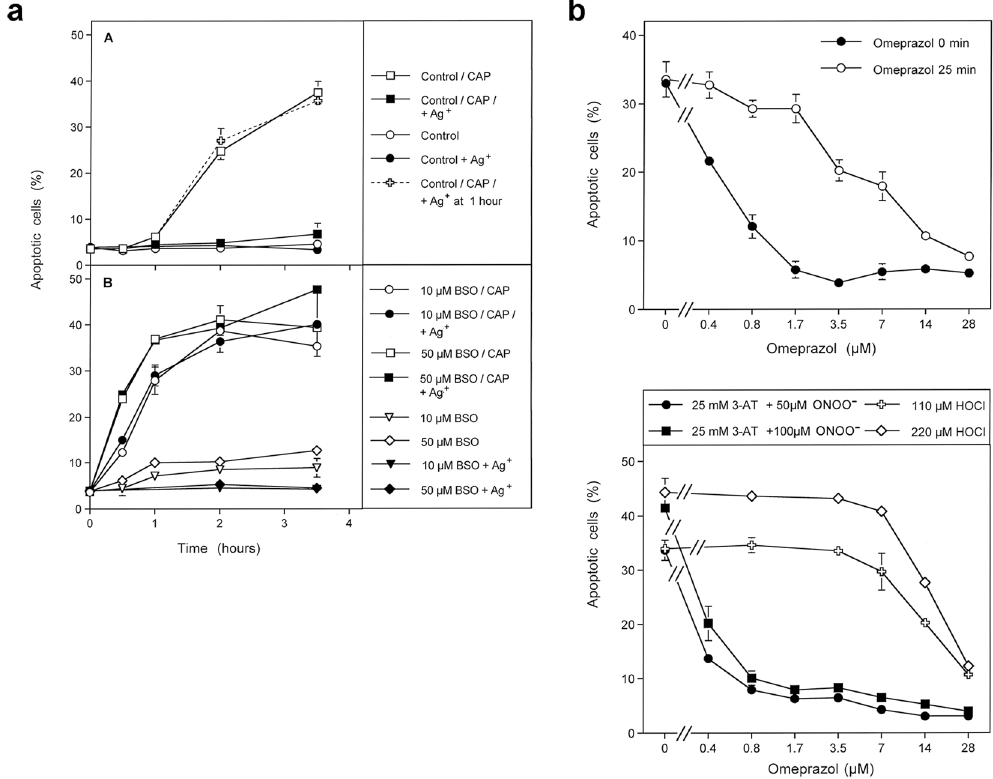
Figure 8. The role of aquaporins and proton pumps for CAP-mediated apoptosis induction. ( a ) The role of aquaporins for intercellular apoptosis-inducing signaling after CAP treatment. Tumor cells were pretreated in the absence of inhibitors (Control) or in the presence of 10 µ M or 50 µ M of buthionine sulfoximine (BSO), an inhibitor for glutathione synthesis, for 14 h. The cells were washed and either received no further treatment, addition of 5 µ M of the aquaporin inhibitor Ag + , treatment with CAP for 1 min plus 25 min incubation or CAP treatment plus Ag + . The percentages of apoptotic cells were determined kinetically. Part A shows that control cells required a 1 hour lag phase before they responded to CAP treatment with apoptosis induction. CAP-mediated apoptosis induction was completely blocked when Ag + had been added at 0 min of incubation, whereas there was no inhibitory effect when Ag + had been added 1 hour after the beginning of the incubation. Part B shows that pretreatment of the cells with BSO, i. e. inhibition and consumption of GSH, allowed for a faster onset of CAP-mediated apoptosis induction that was no longer inhibited by Ag + . Statistical analysis: A: Apoptosis induction after CAP treatment at 2 h and later, as well as inhibition by Ag + added before CAP treatment was highly significant (p < 0.001), whereas addition of Ag + 1 h after CAP treatment was without significant inhibitory effect. B: Apoptosis induction after pretreatment with BSO, followed by CAP treatment was highly significant (p < 0.001), whereas Ag + did not cause significant inhibition. ( b ) The role of proton pumps for CAP-mediated apoptosis induction. Upper graph: The proton pump inhibitor omeprazol was added at increasing concentrations to MKN-45 cells either at the beginning of CAP treatment for 1 min or 25 min after CAP treatment. Apoptosis induction was determined after 3.5 h. The result shows that later effects of CAP treatment are less sensitive to the proton pump inhibitor than earlier ones. Lower graph. Model experiments with omeprazol using defined signaling pathways for apoptosis induction. Increasing concentrations of omeprazol were added to MKN-45 cells that were either treated with the indicated concentrations of the catalase inhibitor 3-AT plus peroxynitrite (ONOO − ) or HOCl. The percentages of apoptotic cells were determined after 2 h. The result shows that ONOO − -mediated apoptosis induction was more efficiently inhibited by omeprazol than HOCl-dependent apoptosis induction. Statistical analysis: Upper graph: When omeprazol had been added at 0 min, the inhibitor caused highly significant inhibition at 0.4 µ M and higher concentrations, whereas it caused highly significant inhibition at 3.5 µ M and higher when added at 25 min (p < 0.001). Lower graph: Inhibition of ONOO − -mediated apoptosis induction was highly significant (p < 0.001) at 0.4 µ M omeprazol and higher, whereas highly significant inhibition of HOCl-mediated apoptosis induction required concentrations of 14 µ M or